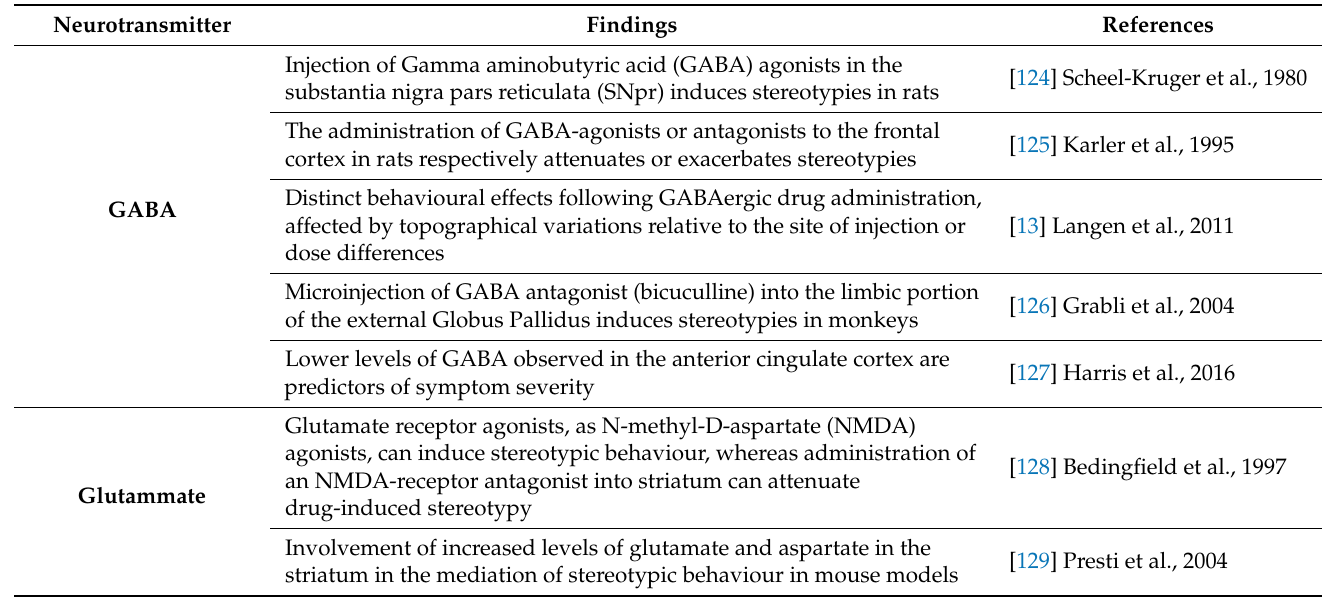
Table 3. Pharmacologically induced repetitive